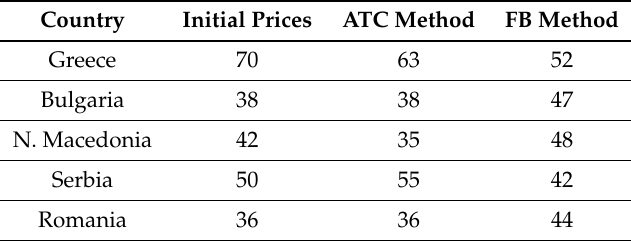
Table 9. Market prices for the 5